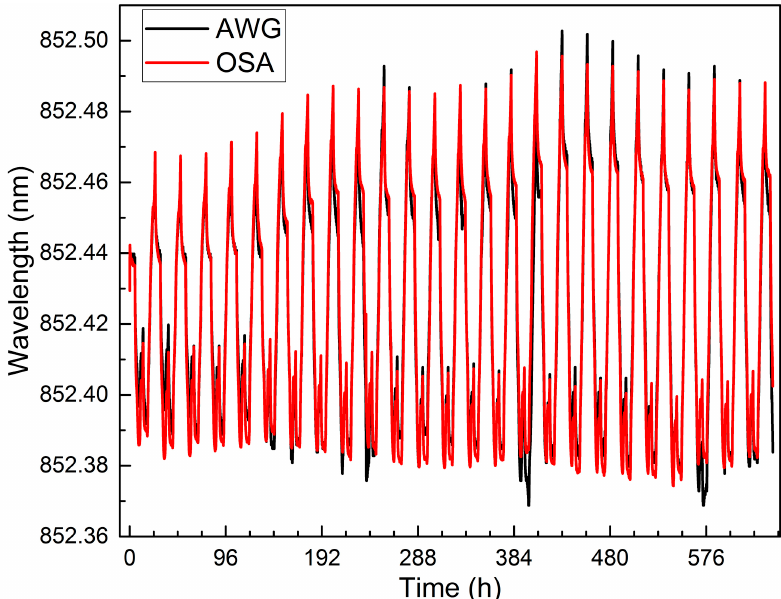
Figure 7. Result of the cyclization experiment. Over 27 days, 25 cycles are performed. The AWG signal is in good agreement to the OSA signal at any time and represents the battery status well.